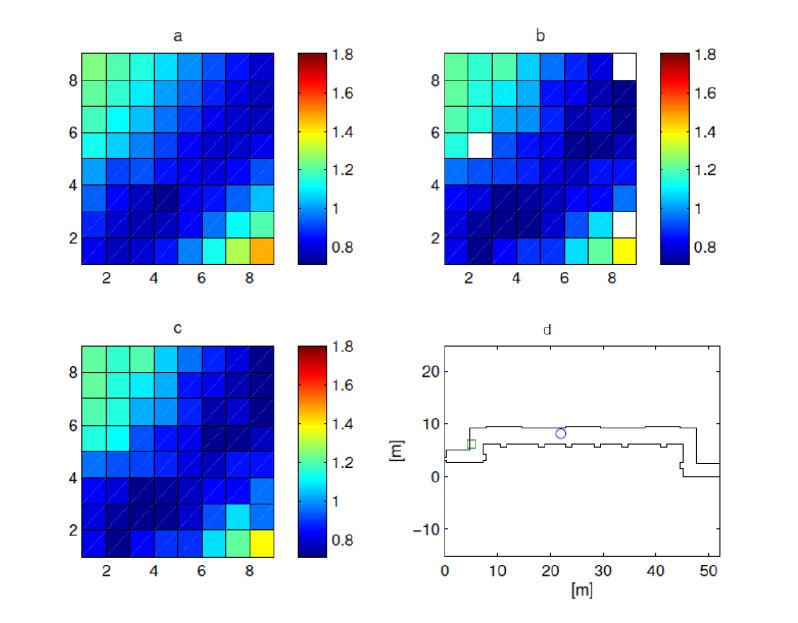
Figure 11. 9 × 9 MIMO system in a corridor; amplitude of the exact (noise-free) ( a ), measured ( b , c ) estimated ( c ) channel matrix; ( d ) geometry of the problem: the position of the transmitting and receiving MIMO systems are plotted as green square and blue circle